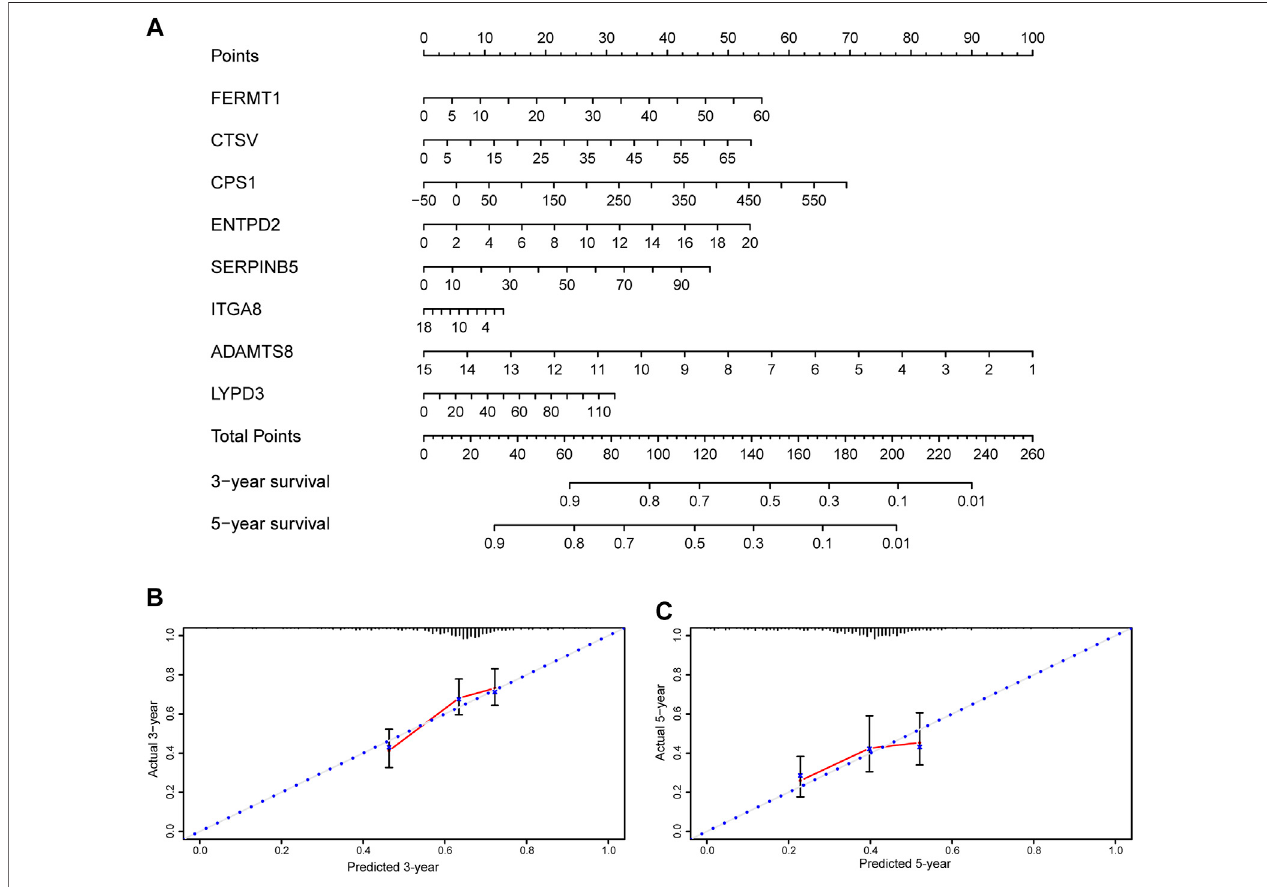
FIGURE 9 | Nomogram and calibration plots of the prognostic signature (A) Nomogram based on eight prognostic ERGs predicting the overall survival probability of patients with lung adenocarcinoma (B,C) The three- and fi ve-years calibration plots of the nomogram. ERGs = extracellular matrix-related genes.